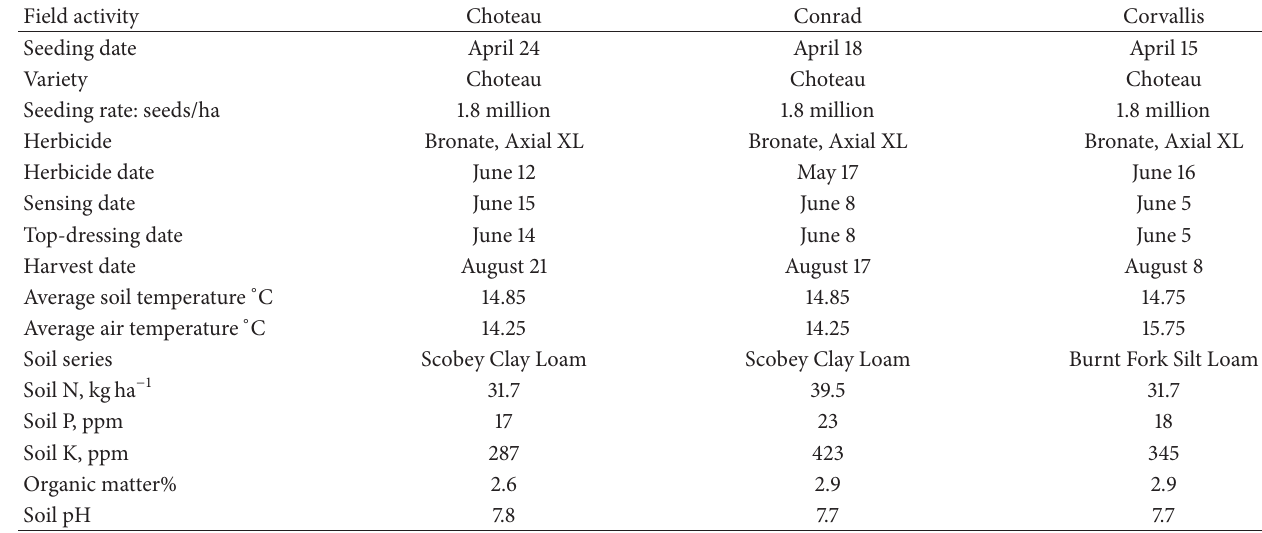
Table 2: Field activities and growing conditions, Conrad, Choteau, and Corvallis, 2012.